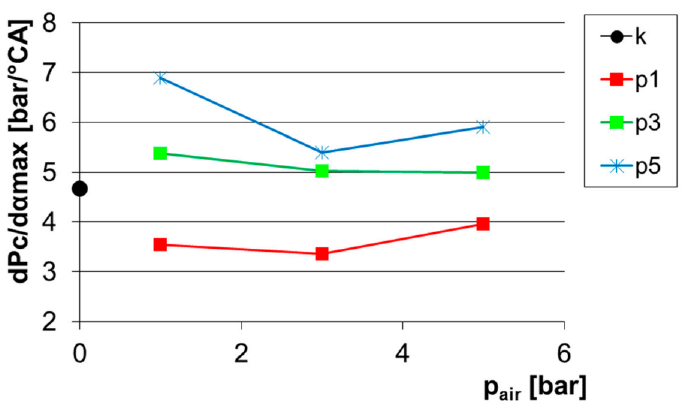
Figure 9. Effect of air supply pressure p air on dP c / d α max .